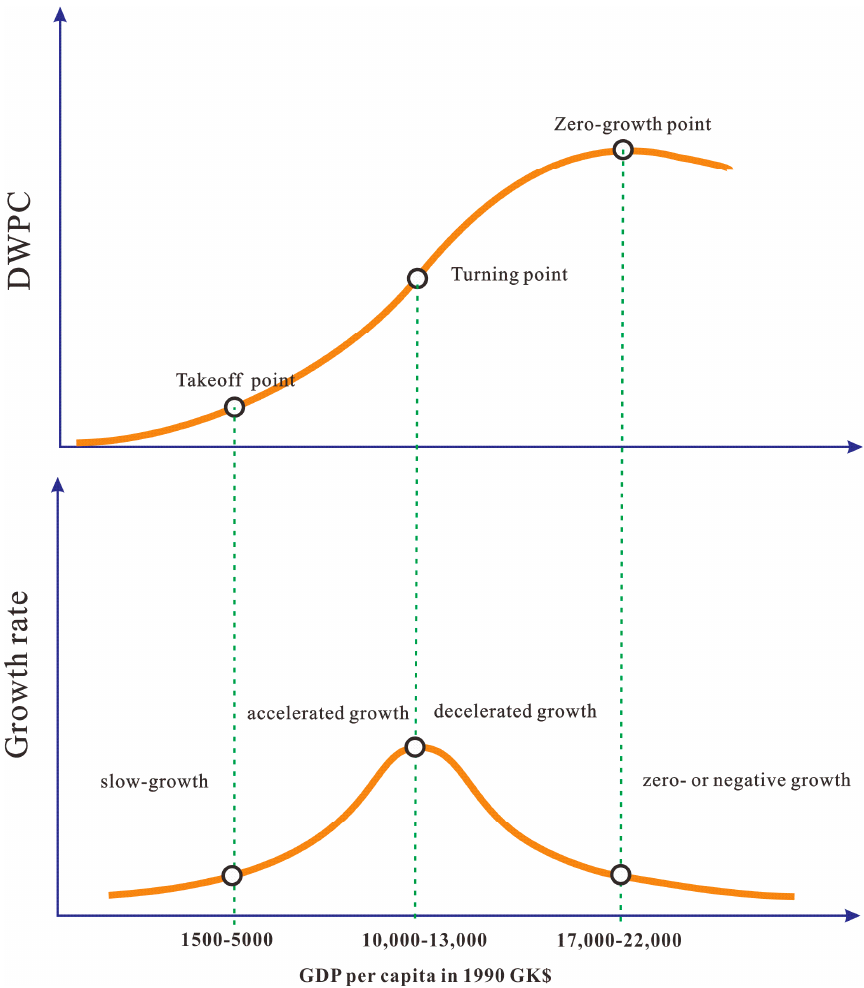
Figure 5. Three key points and four stages with different growth rates of the expanded